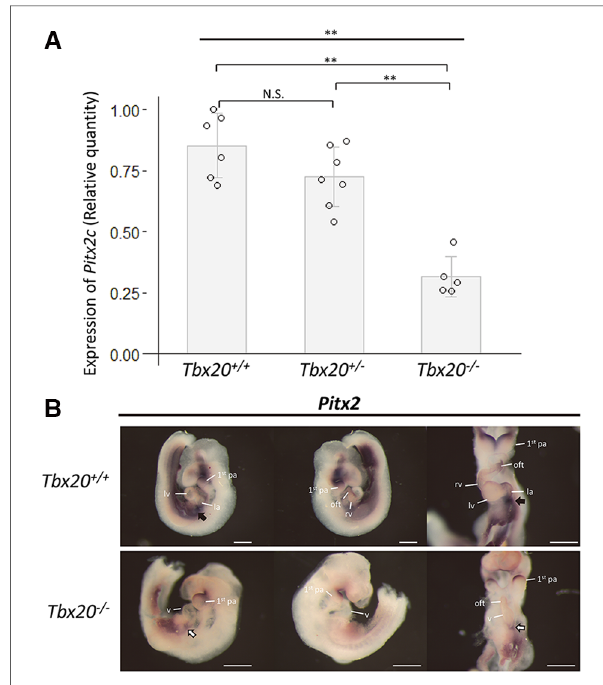
FIGURE 5 Decreased expression of Pitx2 in TBX20 homozygous embryos. ( A ) Quantitative RT-PCR results show the signi fi cant decrease in Pitx2c expression in Tbx20 − / − embryos, compared with that in Tbx20 +/+ or Tbx20 +/ − at embryonic day 9.5. Gapdh was used as internal control. Data were analyzed using one-way ANOVA, followed by Tukey ’ s post hoc test. **, p <0.01; N.S., not signi fi cant. ( B ) Whole-mount in situ hybridization with Pitx2 antisense riboprobe. Pitx2 expression dramatically decreases in the area of the cardiac in fl ows of Tbx20 − / − embryos (white arrows in the lower panels), compared to that of Tbx20 +/+ (black arrows in the upper panels) at embryonic day 9.5. 1st pa; fi rst pharyngeal arch; la, left atrium; lv, left ventricle; oft, out fl ow tract; rv, right ventricle; v, ventricle. Scale bars, 500